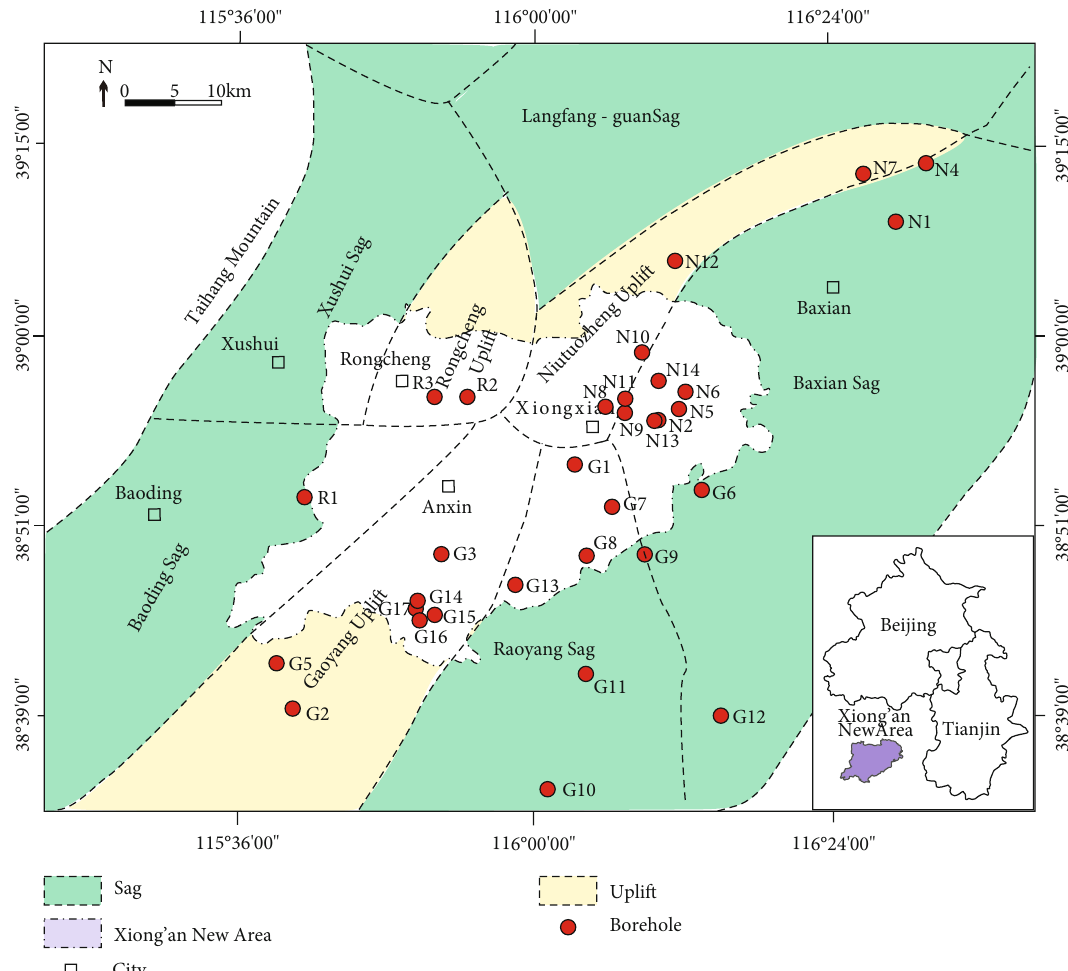
Figure 4: Sampling positions in the Xiong ’ an New Area, North